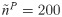
Overview of the tracking algorithm.By exploiting the particle filtering solution, we use n˜P=200 particles sampling the posterior distribution of the motion state of a fruit fly at moment t. Each particle includes two components: the fly’s location (x, y, z) and the fly’s orientation (θ, ϕ). The location component is predicted by using the dynamic model and the fly’s location at moment t−1. After the location component is predicted, an MMP is associated with the particle. Then the orientation component is computed using the MMP. And then the tracking algorithm computes the weight of the particle. If there are more than one MMP (e.g. since the target is associated with two measurements in Camera 1, the algorithm thereby generates two MMPs (χ
1,1, χ
2,2, χ
3,3) and (χ
1,2, χ
2,2, χ
3,3)), the algorithm choose the MMP having highest weight (e.g. (χ
1,1, χ
2,2, χ
3,3)) and the orientation computed by the MMP. Finally, the motion state of the fly at moment t is the expectation computing by the weighted particles.